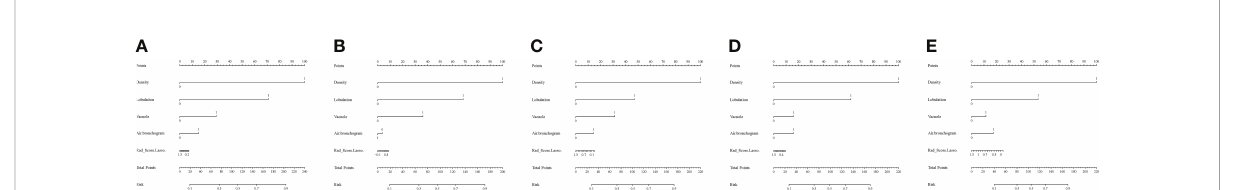
FIGURE 5 Nomograms of the R-R model. (A-E) Fold 1-5 nomograms for the R-R model in the training set. To evaluate the probability of HGP, on each feature axis, a line perpendicular to the point axis was drawn to generate a corresponding point for each feature; the sum of all the points of all features was obtained and then marked on the total score axis, generating a line perpendicular to the risk